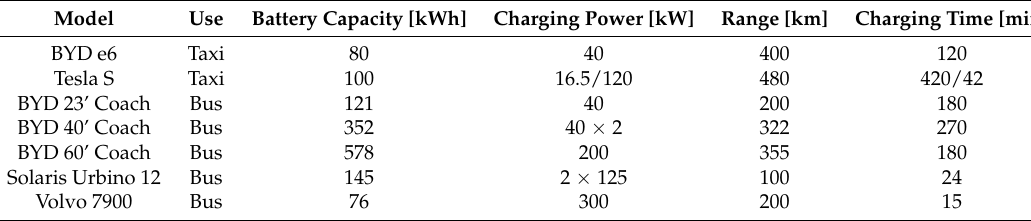
Table 1. Characteristics of EVs for public transportation